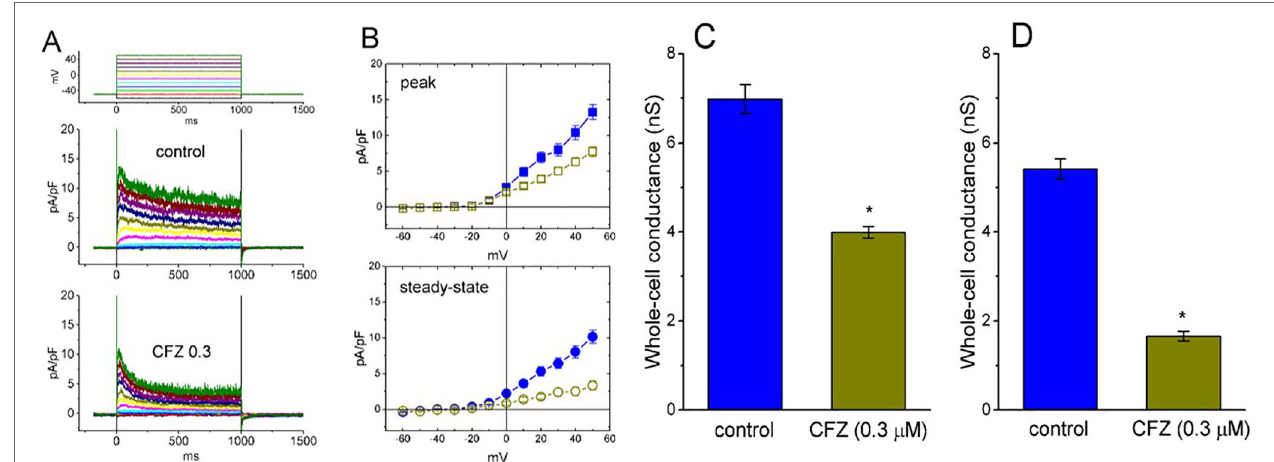
FIGURE 1 | Effect of CFZ on I K(DR) density in GH 3 cells. In these whole-cell current recordings, cells were immersed in Ca 2+ -free Tyrode’s solution and the recording pipette was filled with K + -containing solution. The examined cells were held at −50 mV and different voltage pulses ranging from −60 to +50 mV in 10-mV increments were applied. (A) Representative traces for I K(DR) density taken from the absence (upper; control) and presence (lower; CFZ 0.3) of 0.3 μM CFZ. The upper part in (A) indicates the voltage protocol applied. (B) Averaged current density versus voltage relationships of I K(DR) measured at the beginning (filled symbols; upper [peak]) and end (open symbols; lower [steady-state]) of each depolarizing pulse. The data points in the upper (peak) and lower (steady-state) panels were obtained from the absence (square symbols) and presence (circle symbols) of 0.3 μM CFZ, respectively. Each data point represents mean ± SEM (n = 9). Summary bar graphs in (C) and (D) respectively show the whole-cell conductances of I K(DR) at the beginning (i.e., peak conductance) and end (i.e., steady-state conductance) of depolarizing pulses ranging between 0 and +50 mV (mean ± SEM; n = 8 for each bar). *Significantly different from controls ( P <